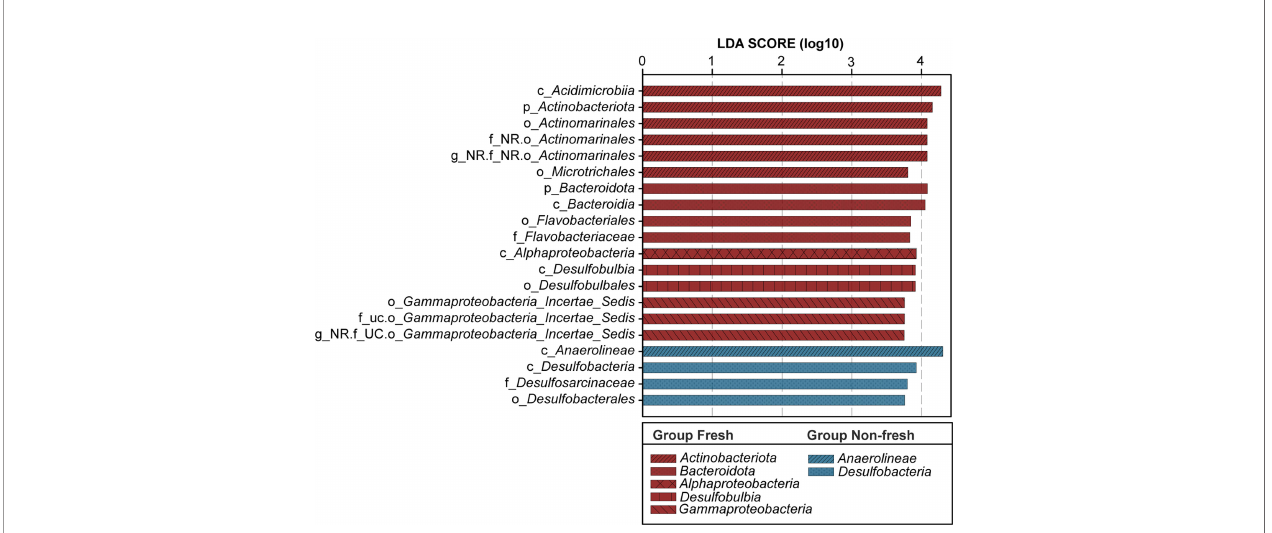
FIGURE 8 | LEfSe analysis revealed the taxa that are signi fi cantly different between two groups base on the relative abundance. According to the ranking of LDA score from large to small, the top 20 taxa are shown in the fi gure with different colors and